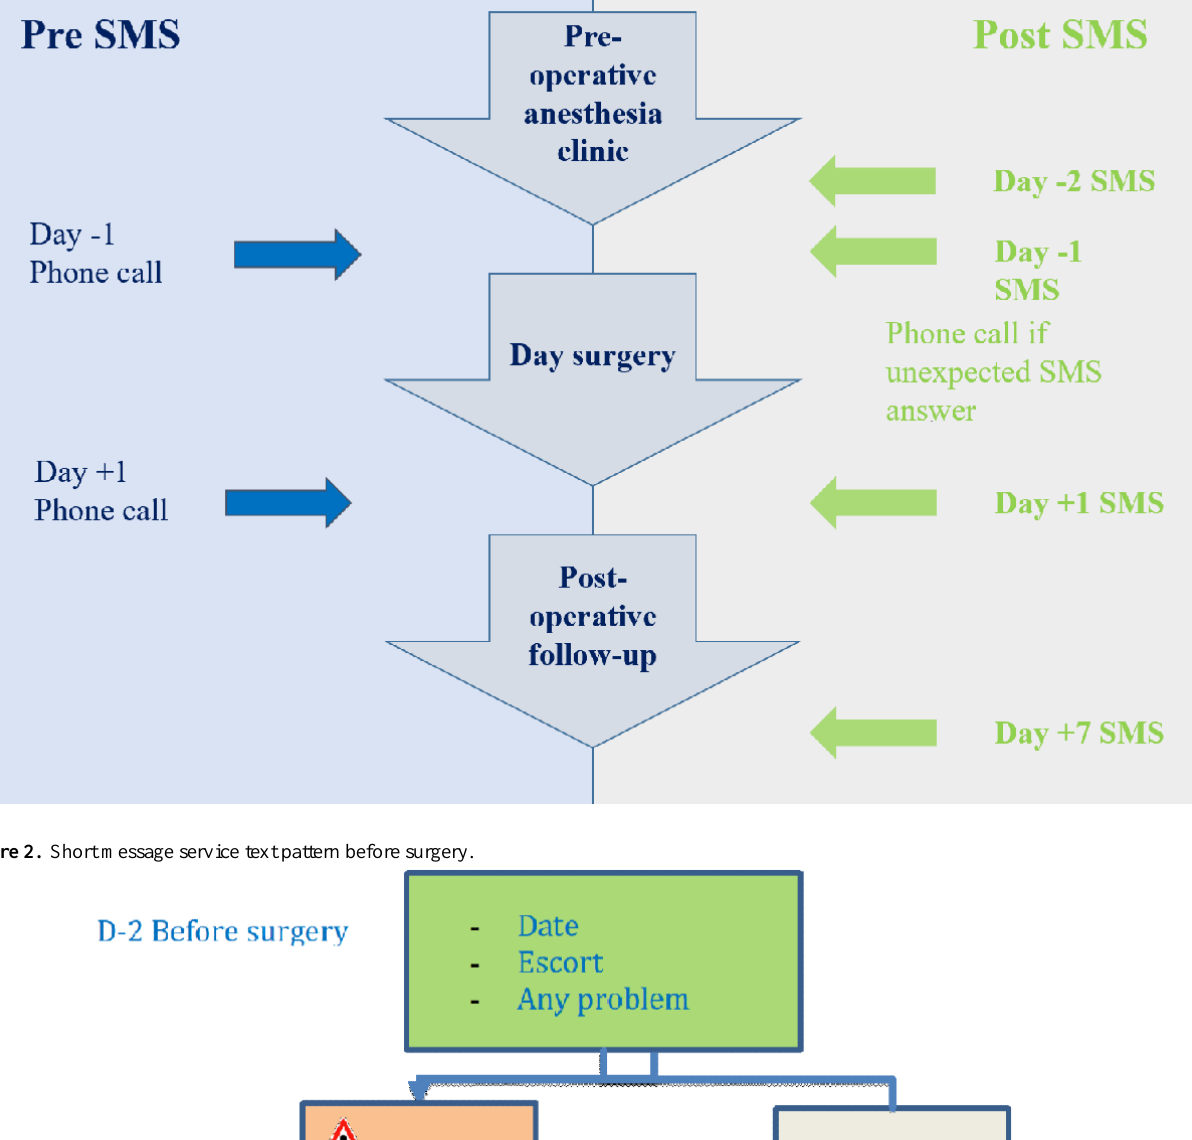
Figure 1. Course in outpatient surgery before and after short message service text reminders.